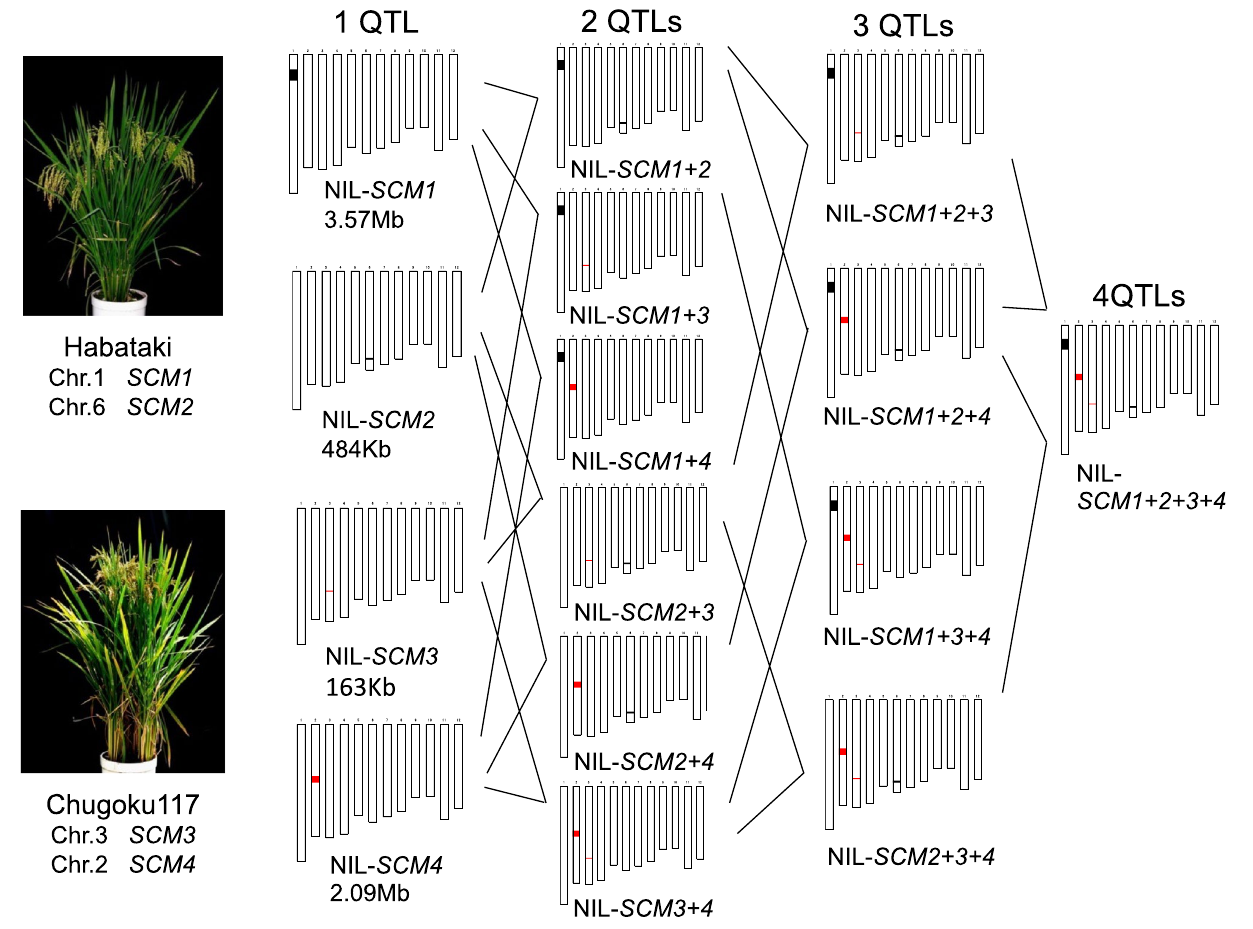
Figure 1. The breeding process for the pyramiding lines. Pyramiding lines with double NILs (SCM1 + 2, SCM1 + 3, SCM1 + 4, SCM2 + 4, SCM2 + 3, SCM3 + 4), triple NILs (SCM1 + 2 + 4, SCM1 + 2 + 3, SCM1 + 3 + 4, SCM2 + 3 + 4), and a quadruple NIL (SCM1 + 2 + 3 + 4) were developed. These combinations were derived from step-by-step crosses among NIL-SCM1–NIL-SCM4. Habataki segments of 3.57 Mb and 484 kb were introgressed in NIL-SCM1 and NIL-SCM2 of the Koshihikari genetic background. Chugoku 117 segments of 163 kb and 2.09 Mb were introgressed in NIL-SCM3 and NIL-SCM4 of the Koshihikari genetic